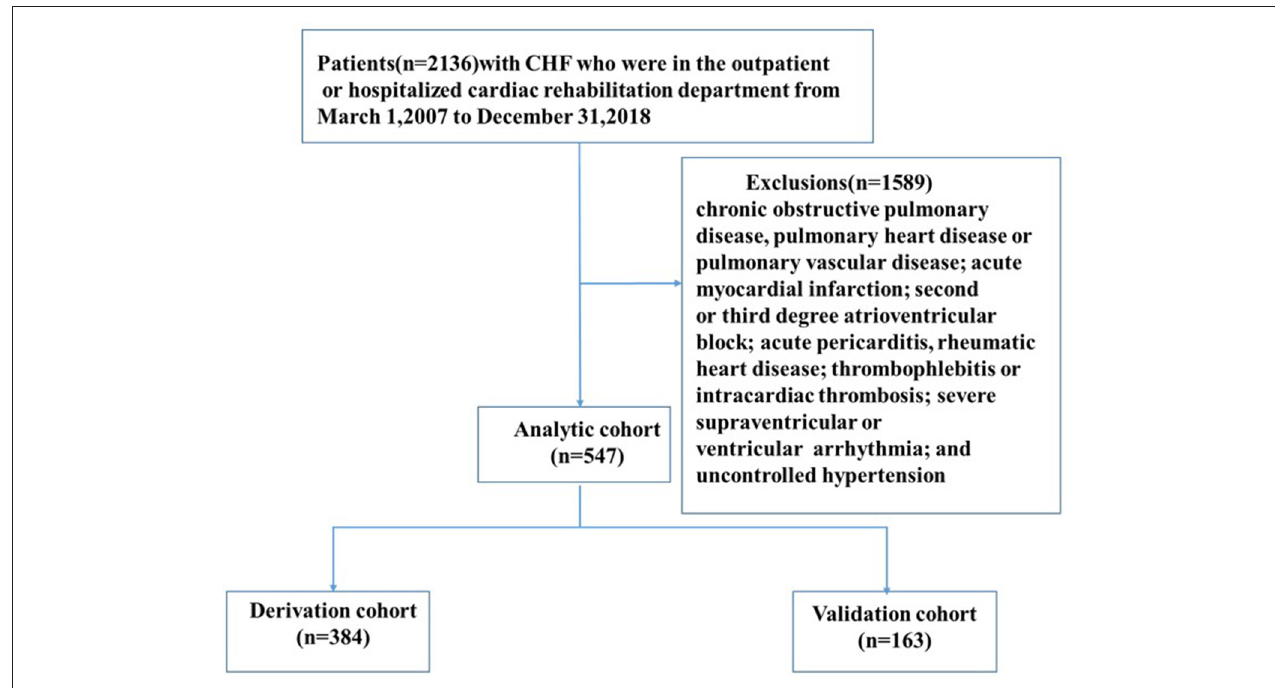
FIGURE 1 | Study flow. CHF, chronic heart